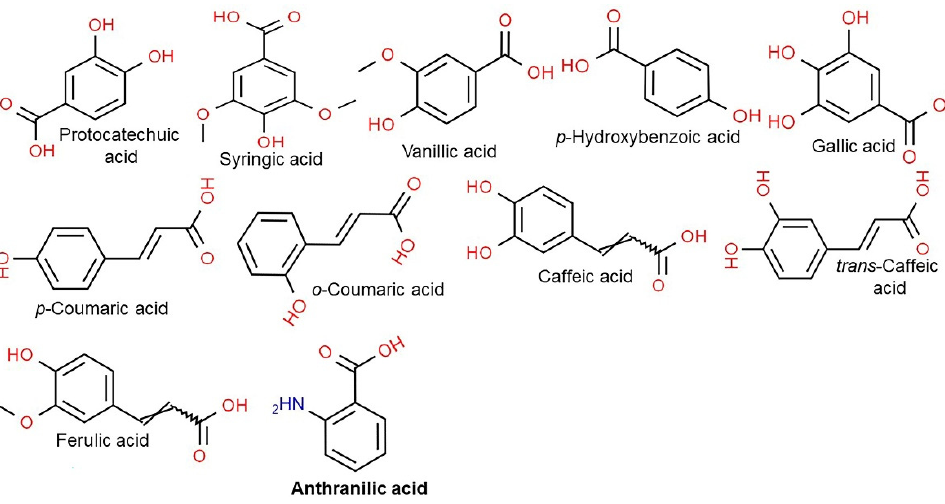
Figure 6. Chemical structure of main polyphenolic compounds found in oats.